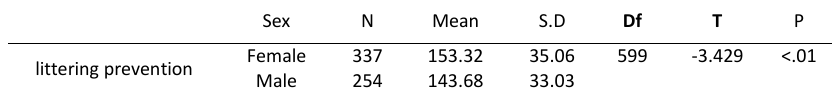
Table 2: Summary of t-test for the independent samples showing the influence sex on littering prevention